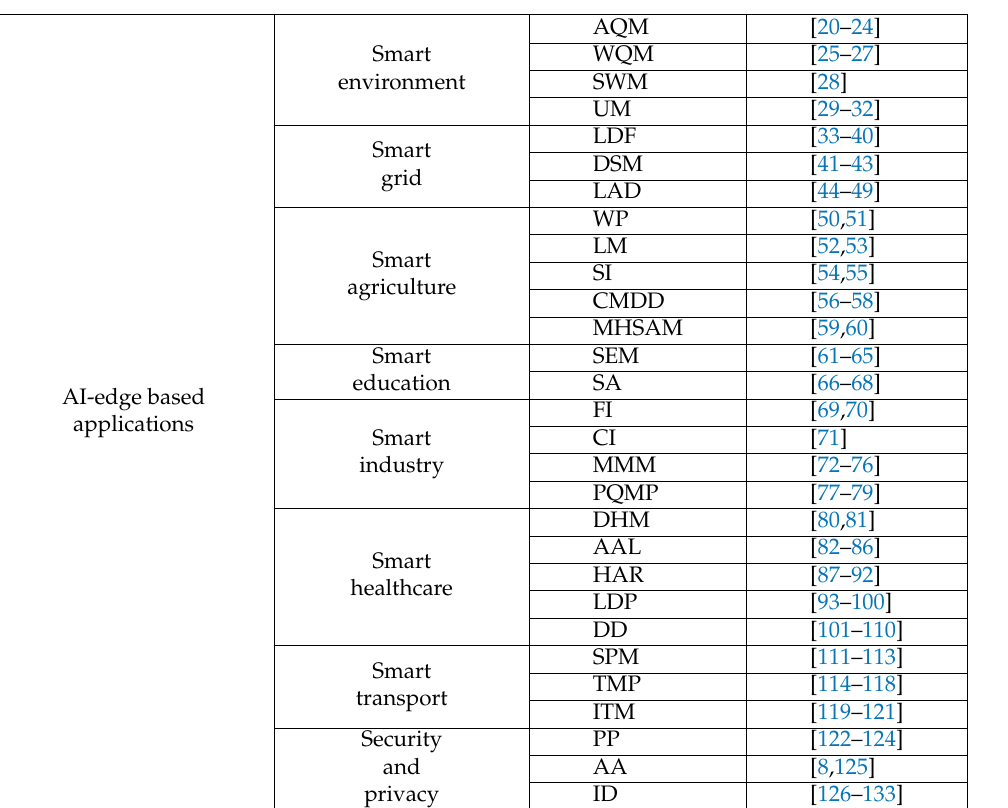
Table 2. Taxonomy of the reviewed